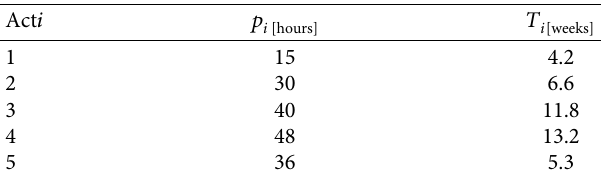
Table 2: Input parameters of the maintenance activities involved in the comparative case